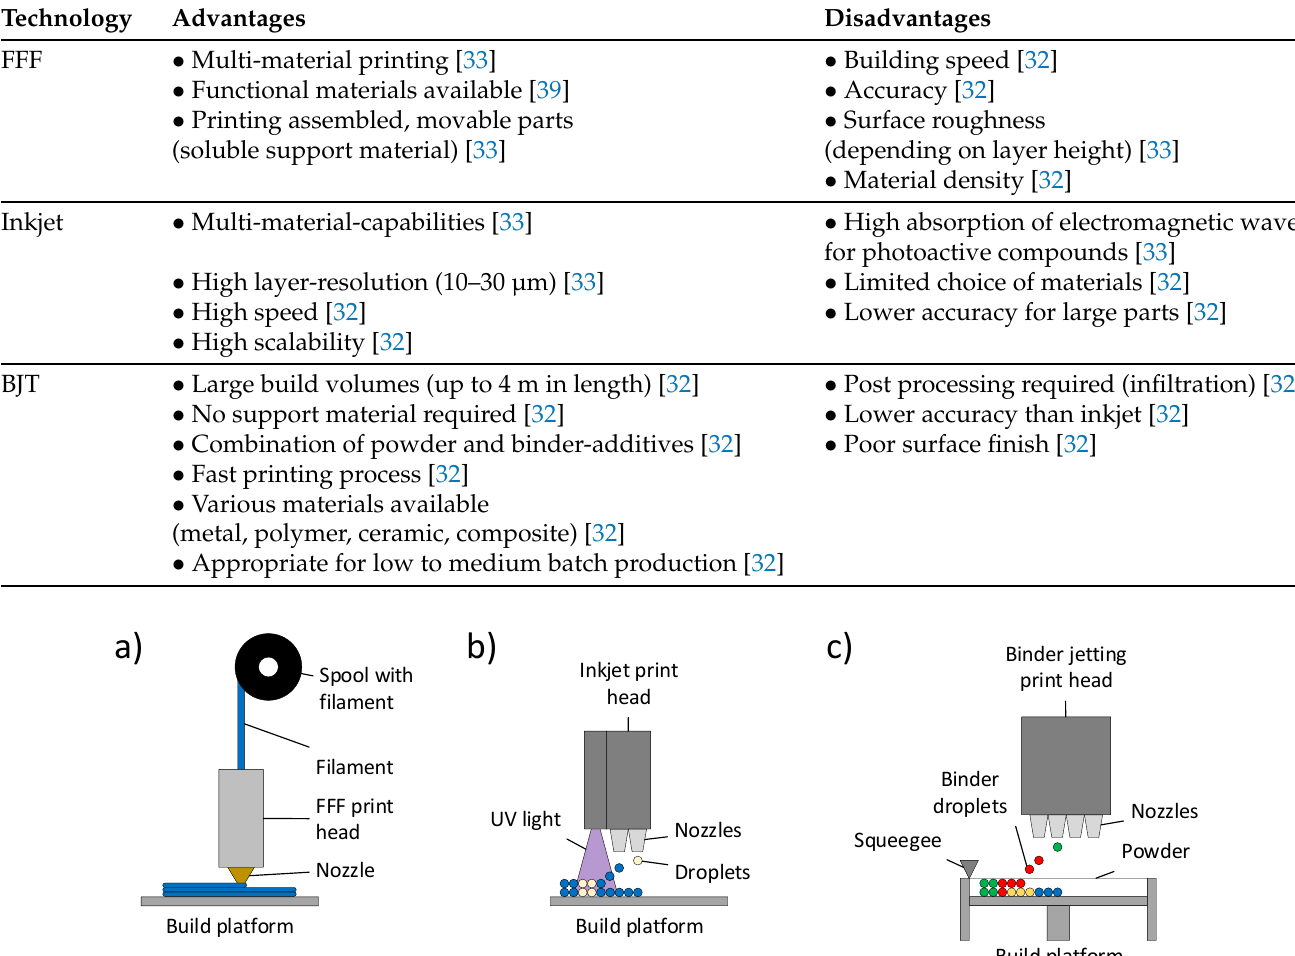
Table 1. Advantages and disadvantages of Fused filament fabrication (FFF), Inkjet, Binder Jetting (BJT). Technology